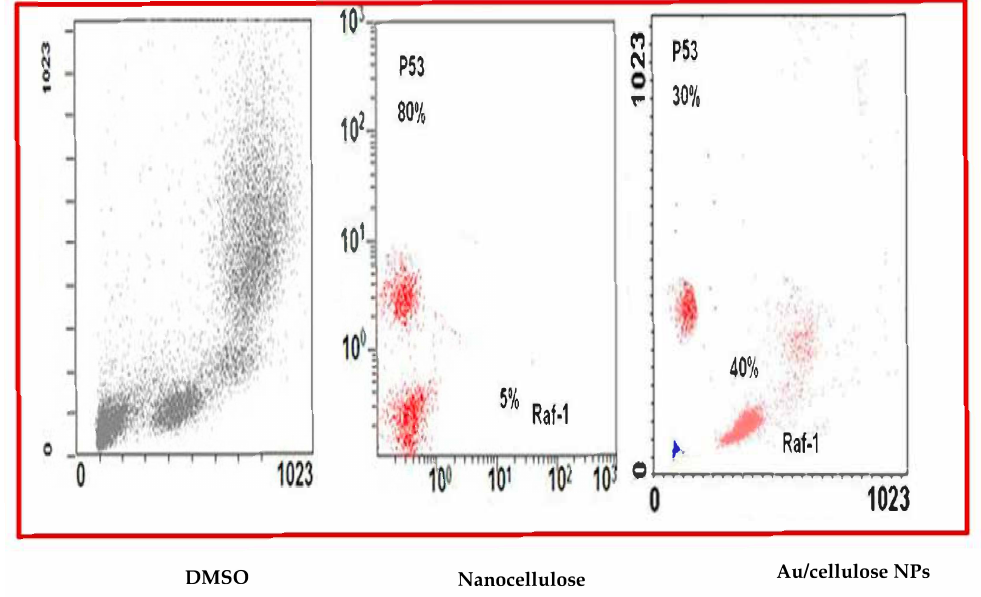
Figure 9. Quantified protein profile of both Raf-1 and pho-P53 in A549 treated by nanocellulose and Au/cellulose nanocomposite indicated by flow cytometry and compared to DMSO-treated